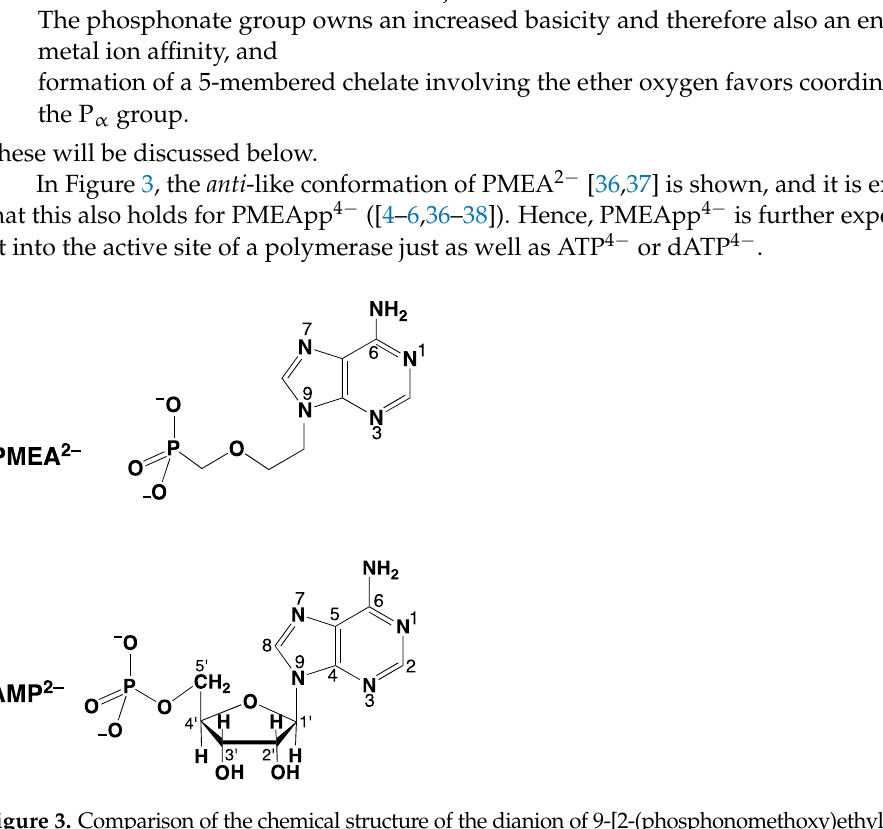
Figure 3. Comparison of the chemical structure of the dianion of 9-[2-(phosphonomethoxy)ethyl]adenine (PMEA 2 − ) with the one of adenosine 5 ′ -monophosphate (AMP 2 − ). The orientation of PMEA 2 − in solution [36] and in the solid state [37] resembles the anti conformation of AMP 2 − [4–6,38] and thus PMEA 2 − may be considered as an analogue of AMP 2 − or 2 (cid:48) -deoxy-AMP 2 −